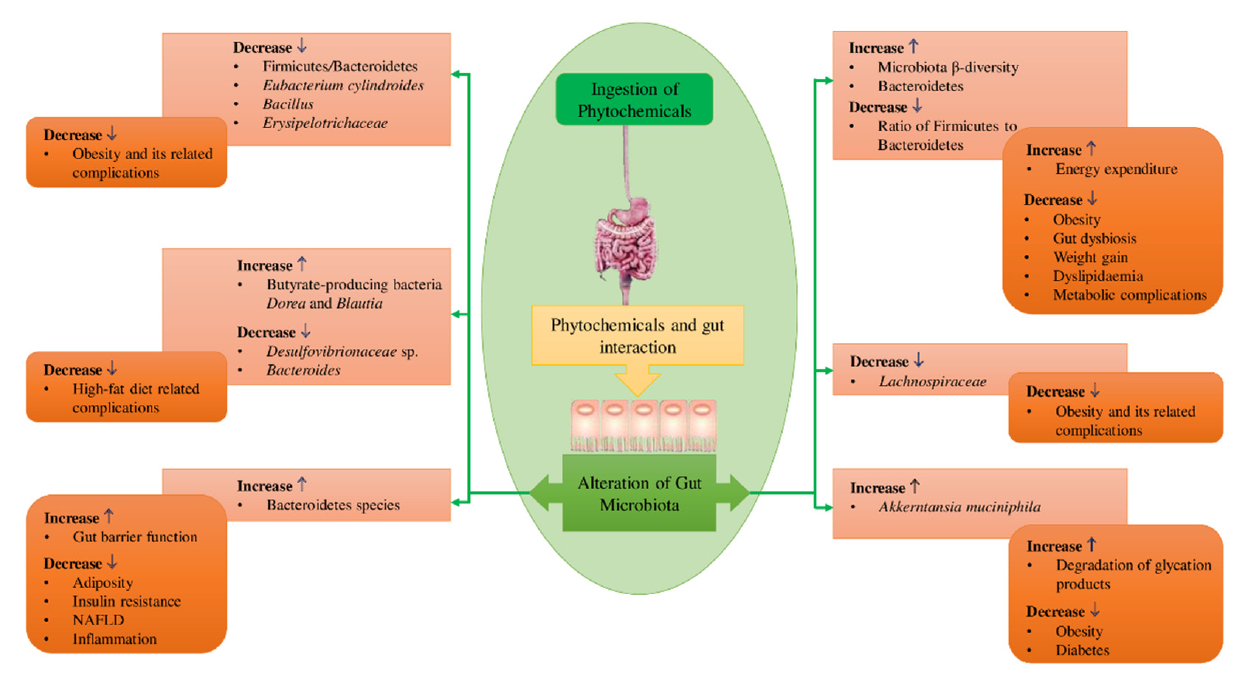
Figure 17. Impact of phytochemicals and diet rich in phytochemicals on metabolic diseases by modifying intestinal microflora (self ‐ generated).